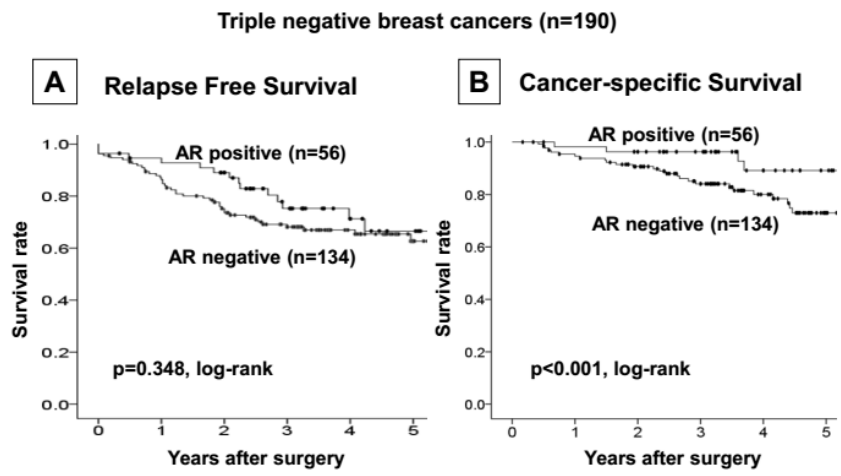
Figure 2. Cancer specific and relapse-free survival of patients based on AR expression in triple-negative breast cancers. AR expression cases had significantly good prognosis compared to the non-expression cases ( A ), but no significant difference in relapse-free survival rate was observed between AR-positive and negative triple-negative breast caluncer (TNBC) cases ( B ).